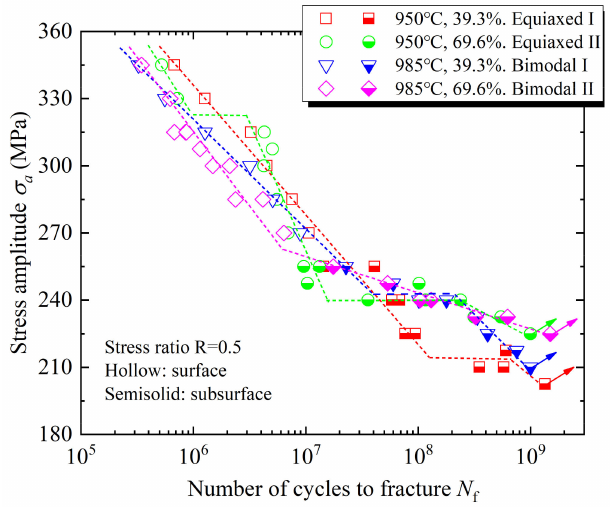
Figure 6. S-N curves of different forged TC4 titanium